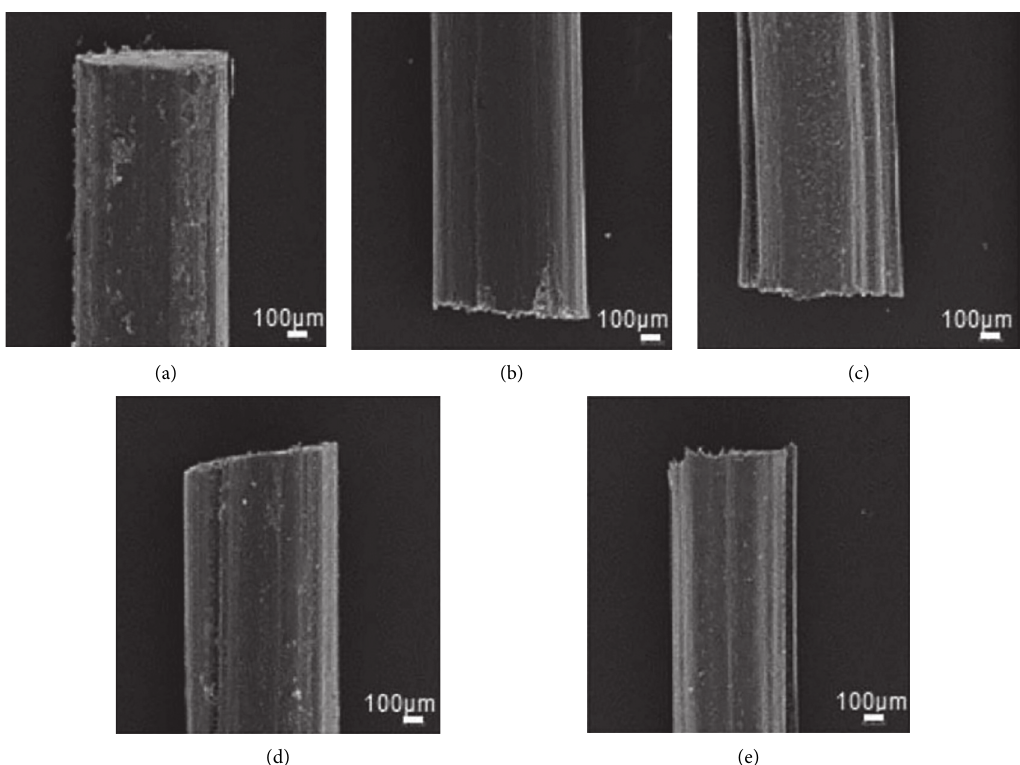
Figure 1: 5% NaOH-treated alfa fiber at different time intervals: (a) raw fiber, (b) 2 h, (c) 4h, (d) 6h, and (e) 24h [174].